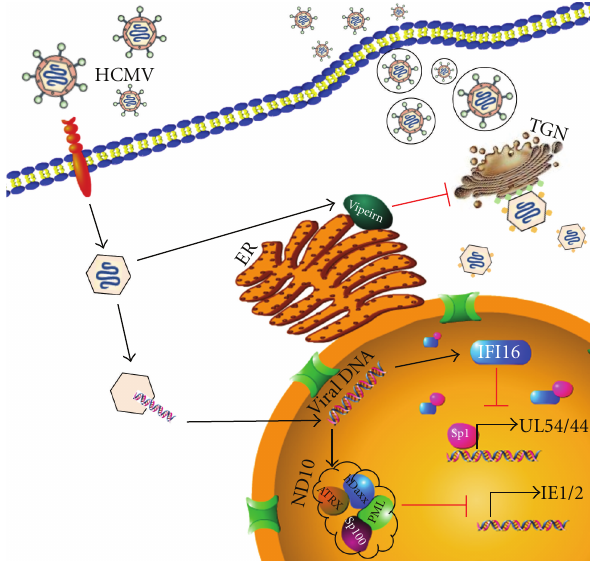
Figure 2: Type I IFN restriction factors that target HCMV.